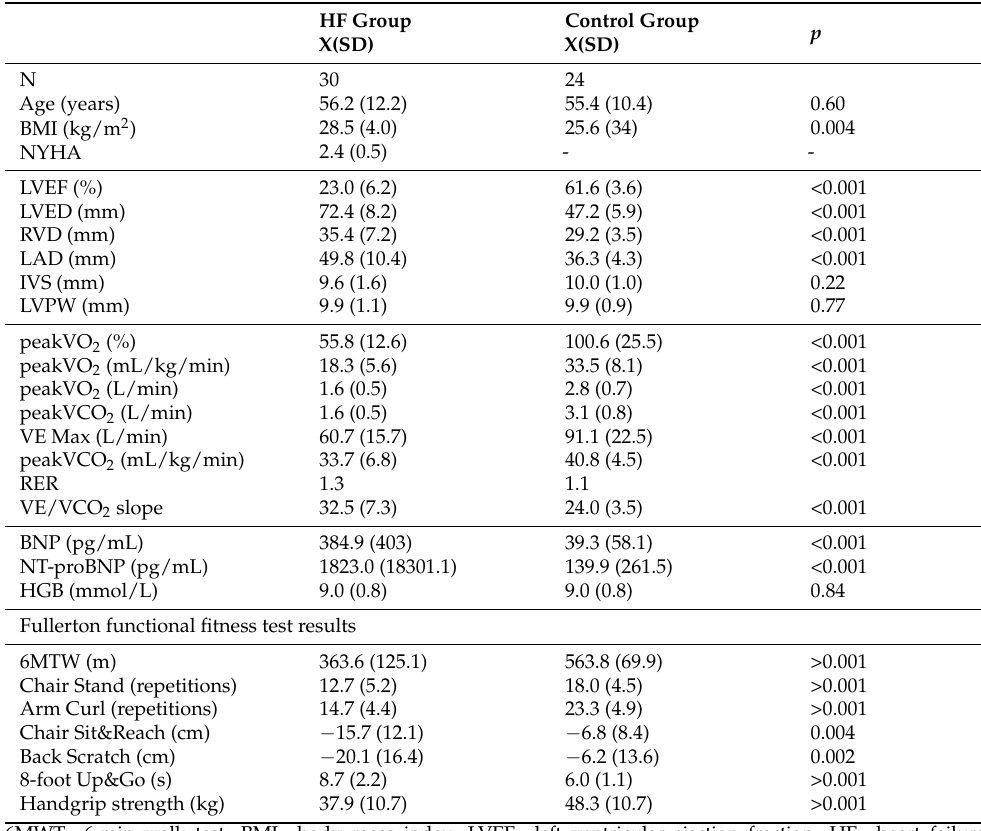
Table 3. Baseline study population